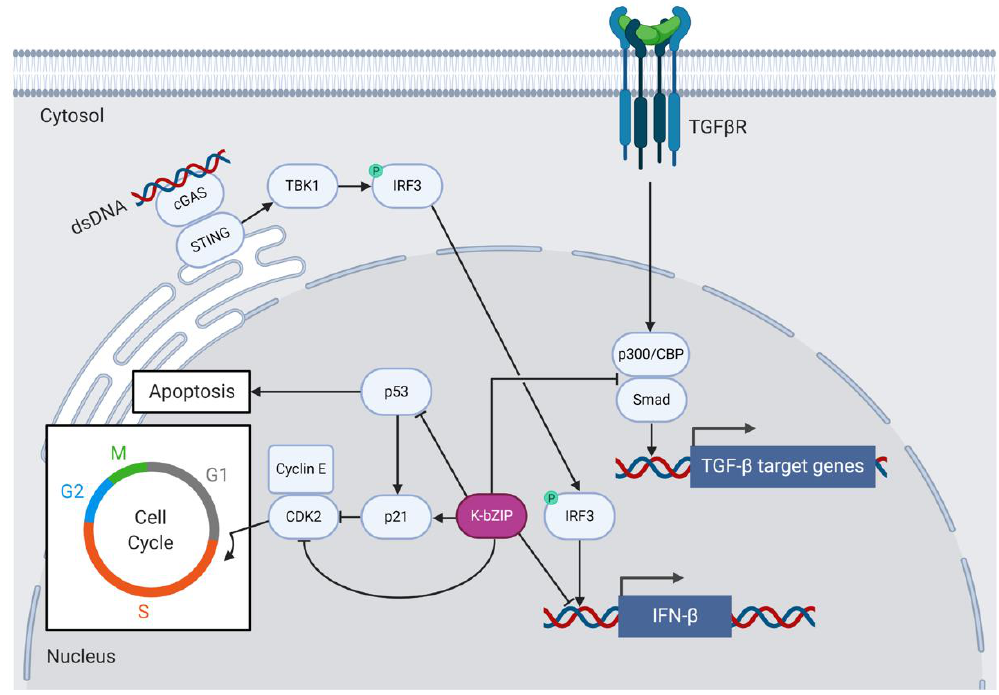
Figure 3. K-bZIP inhibits antiviral innate immune signaling and anti-proliferative signaling.